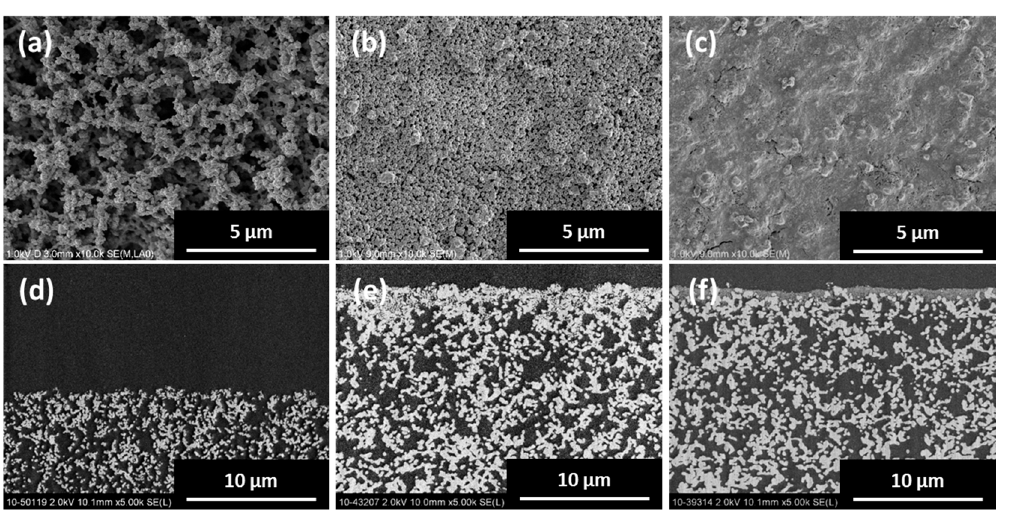
Figure 2. Top (upper row) and cross-sectional (lower row) SEM images of silica support ( a , d ) before and after coating of top surface with ( b , e ) spherical silica and ( c , f ) fumed silica.